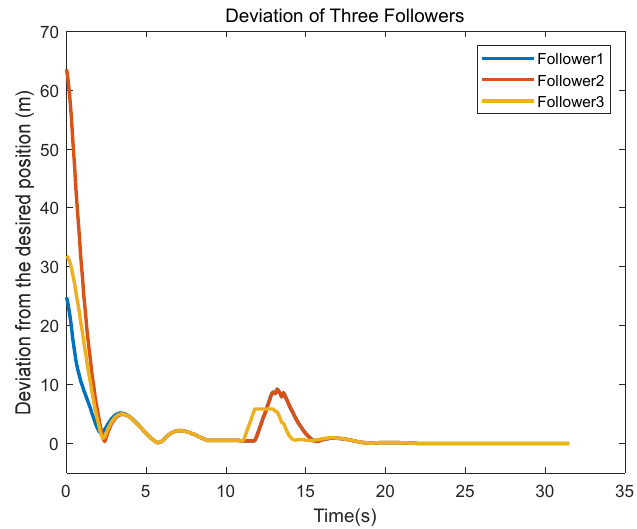
Figure 17. Deviation values of three followers from the desired position.